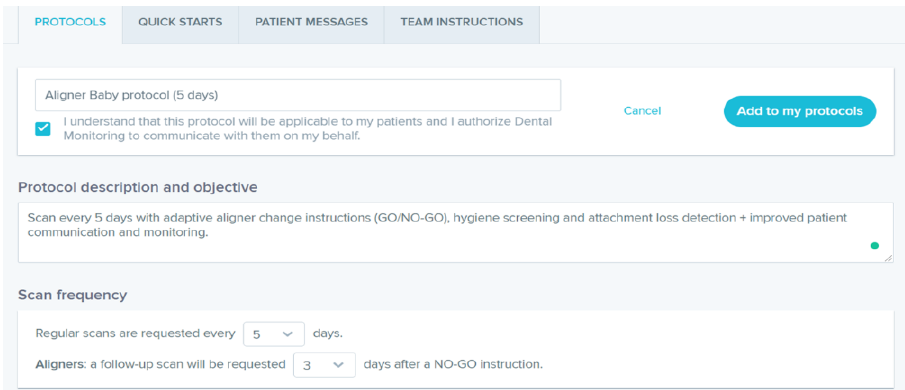
Figure 3. Personalized protocol used by the orthodontist.